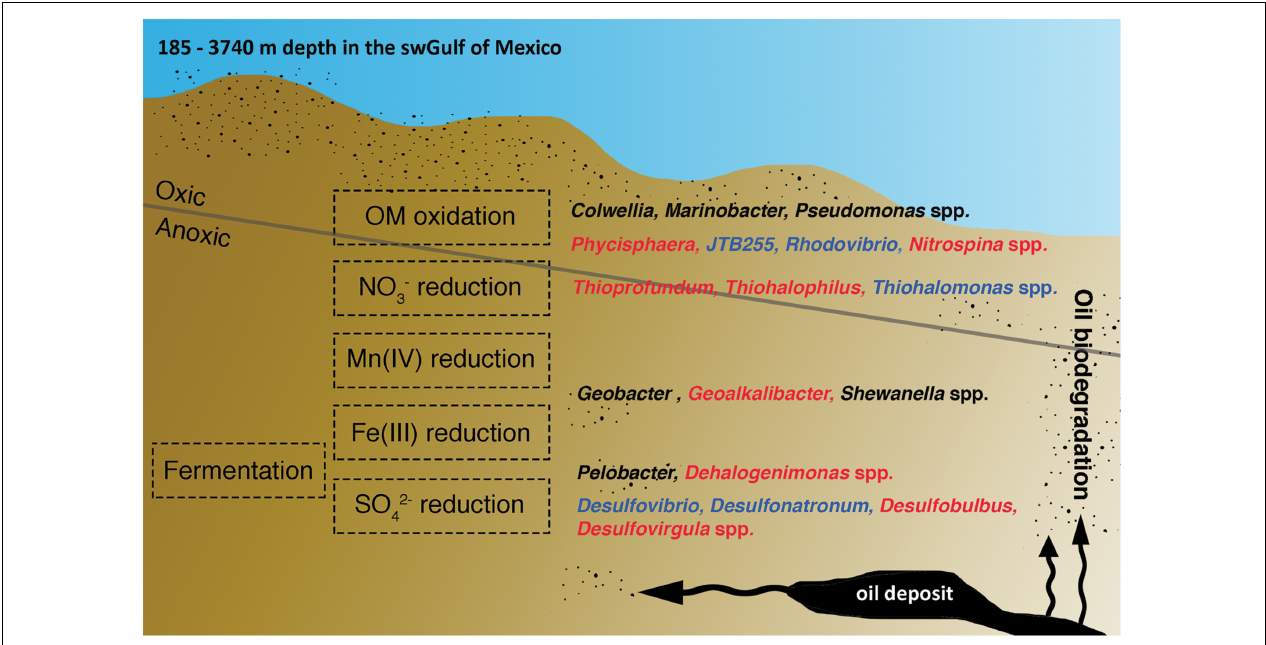
FIGURE 6 | Hypothetical summary of the niche with the most abundant genera in the swGoM according to electron acceptor stratification. Blue indicates the genera that are common to marine sediments. Red and black indicate genera characteristic of the swGoM, and black indicates potential HDB.